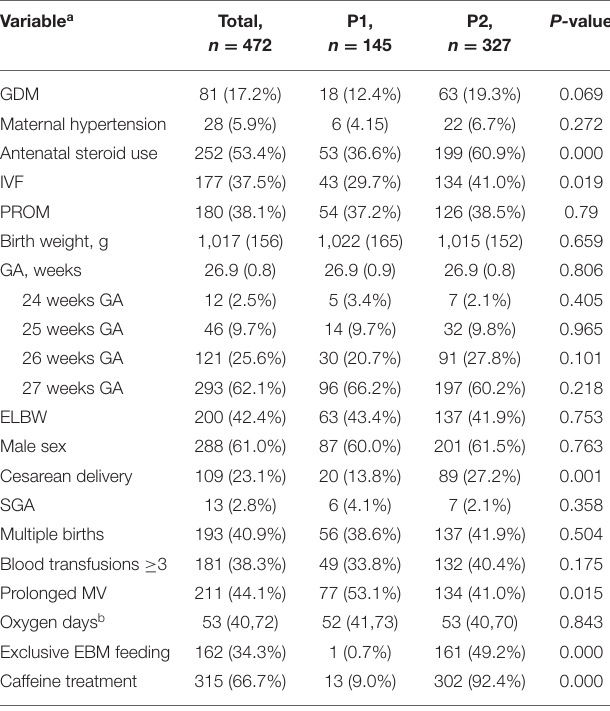
TABLE 4 | Comparing basic characteristics and therapies in 472 extremely preterm infants who completed ROP screening in P1 (2010–2014) and P2